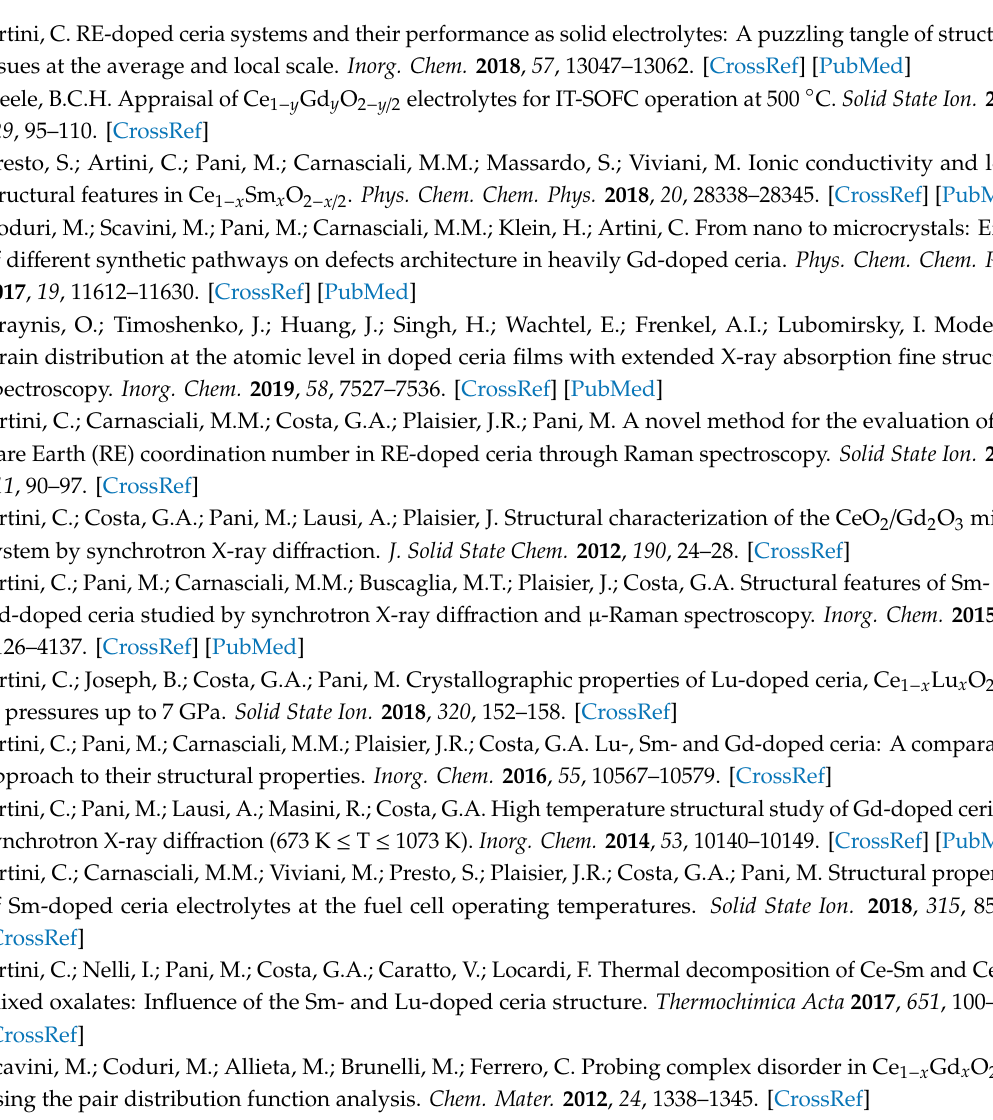
Table S1: Hybrid structural model compared to the F structure typical of CeO 2 and the C structure typical of sesquioxides of heavy rare